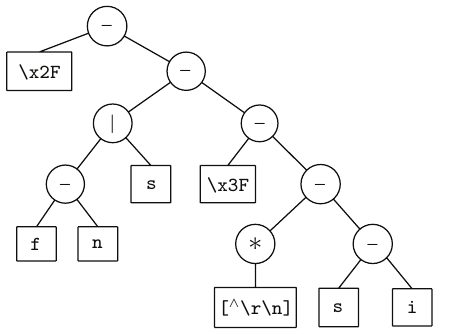
Figure 3: Parse-tree representation of “ \ x2F ( fn | s ) \ x3F [ (cid:2) \ r \ n ] ∗ si .”